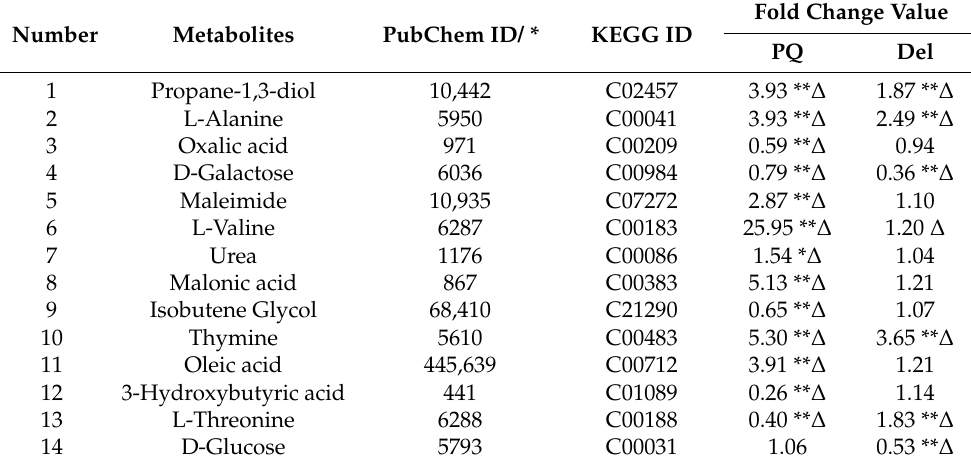
Table 1. Statistical analysis of differential metabolites in PQ and Del treatment